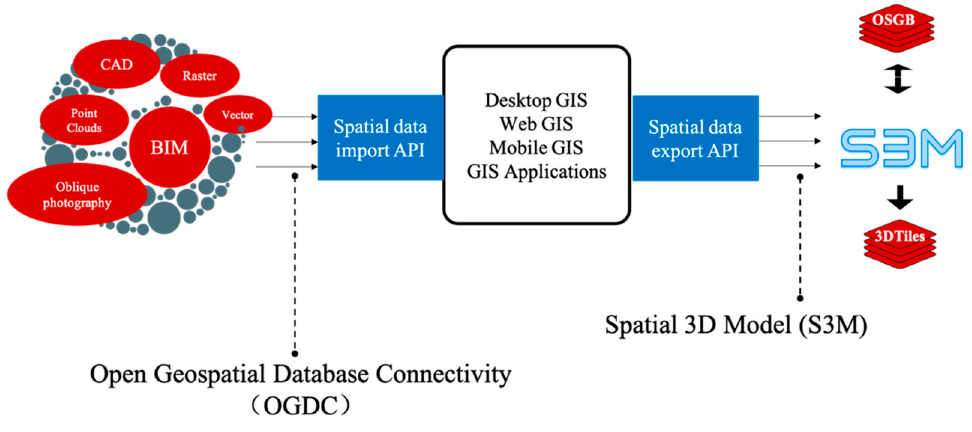
Figure 7. The heterogeneous geospatial data fusion framework.